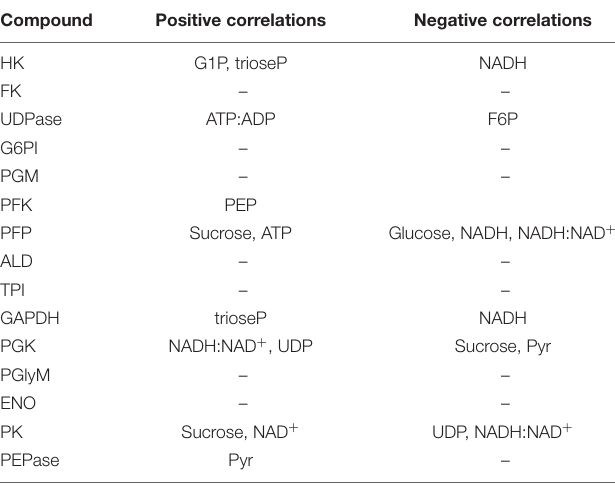
TABLE 5 | Significant correlations between glycolytic enzyme activities and glycolytic pathway metabolites, ATP:ADP ratio, and NADH:NAD + ratio in roots during 60 days storage ( α = 0.05).